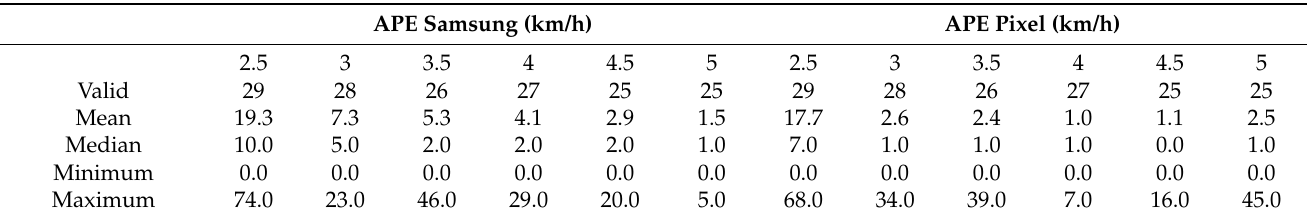
Table 2. The average percentage error of the Samsung and Pixel devices split into the 6 test speeds.